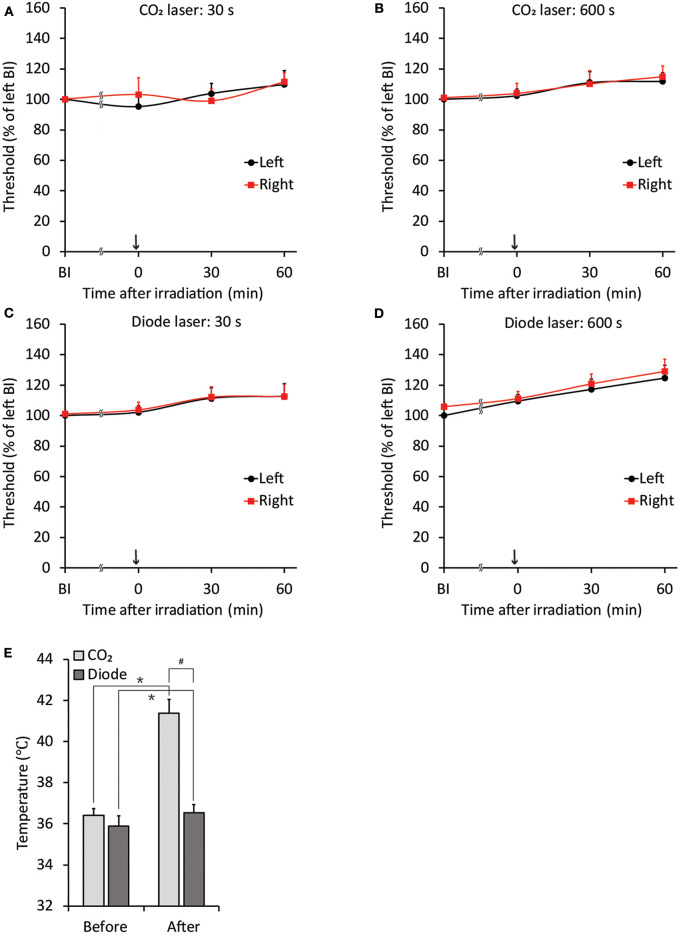
Stability of jaw-opening reflex excitability and temperature alterations after laser irradiation in rats without application of orthodontic force. (A–D) There were no significant differences between the left- and right-side thresholds for inducing the jaw-opening reflex (BI). The application of CO2 (A: 30 s, B: 600 s) or diode (C: 30 s, D: 600 s) laser irradiation did not alter jaw-opening reflex excitability. (E) CO2 laser irradiation significantly increased the surface temperature of the right maxillary first molar gingiva. BI: before laser irradiation. Arrow: laser irradiation. Before: before irradiation. After: after irradiation. Paired t-test, *p < 0.05, Student's t-test, #p < 0.05.